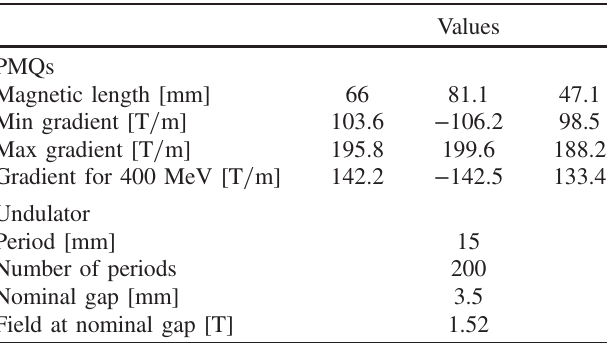
TABLE III. COXINEL magnets ’ relevant parameter for the 40 nm wavelength case using a 400 MeV beam. The three values for PMQs are for each PMQ of the triplet in the beam propagation order.